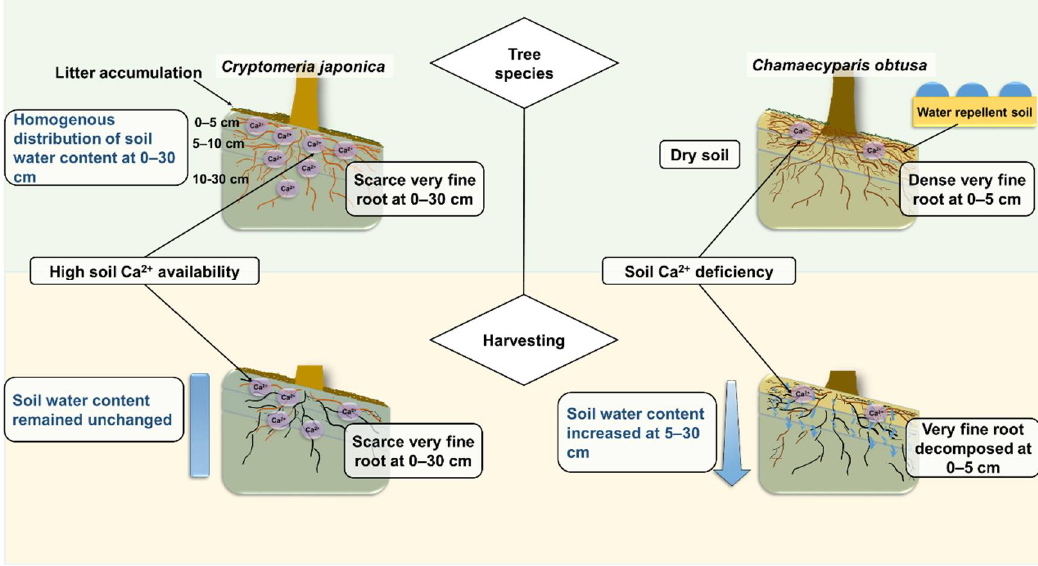
Figure 5. Schematic diagram of research results.